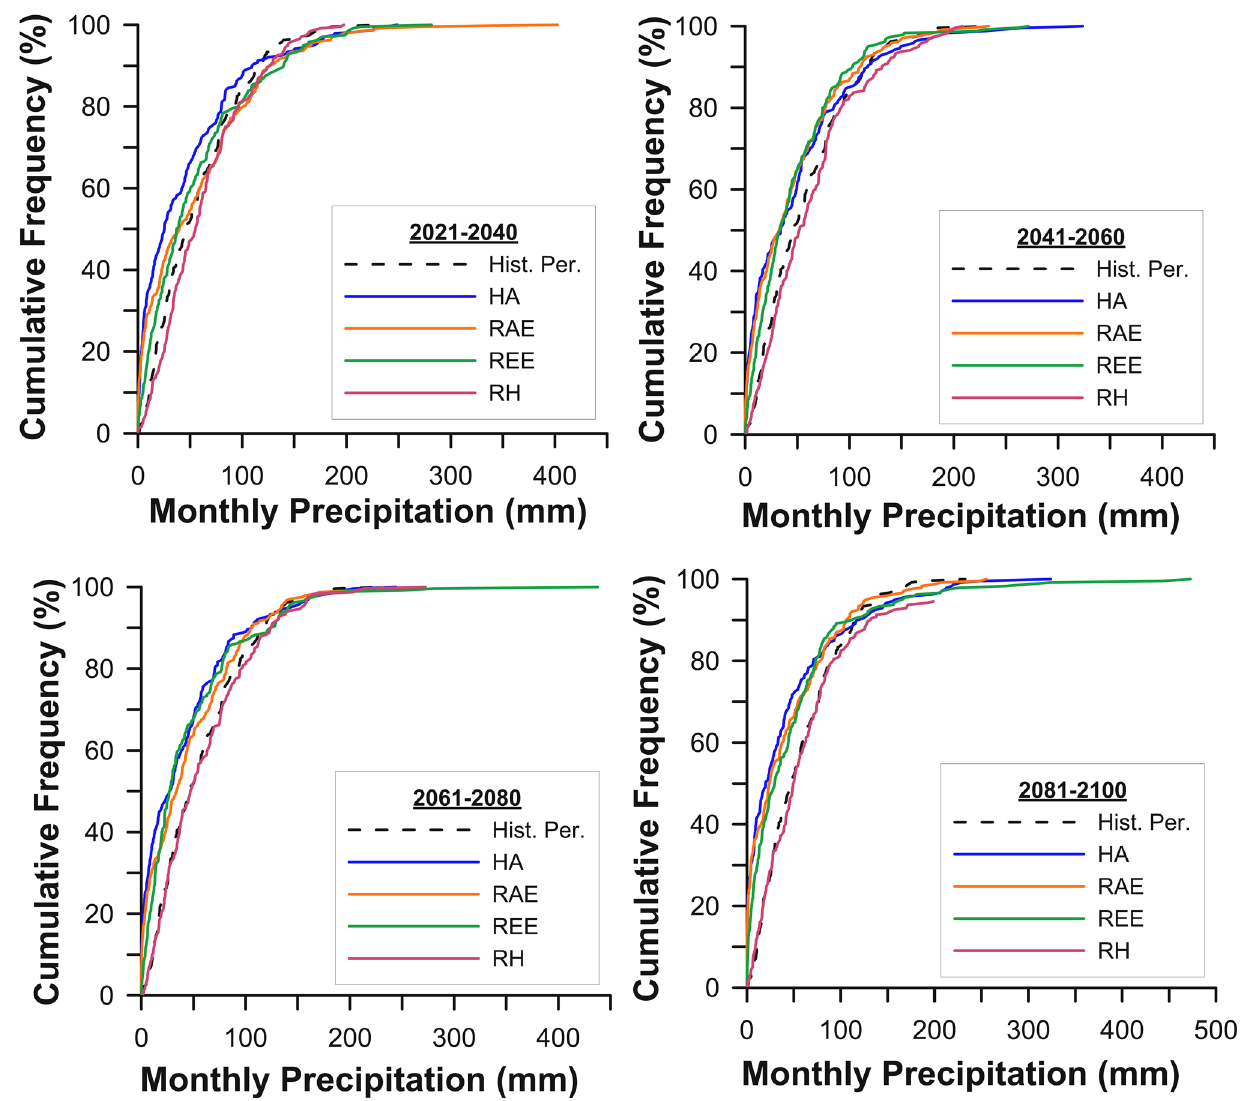
Fig. 6 Cumulative frequency diagrams of monthly precipitation for the historical period (1981–2000) and all RCM–GCM combinations at the four